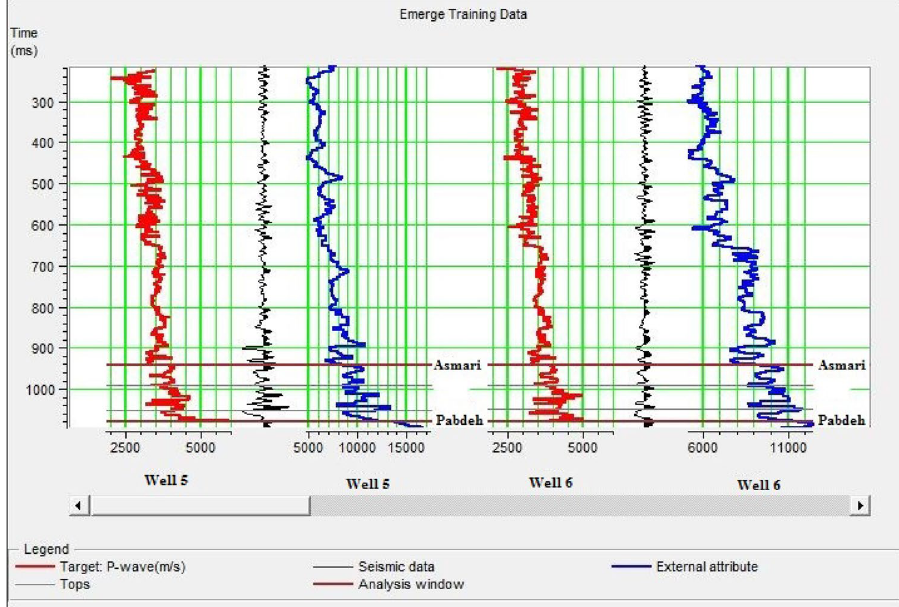
Fig. 12 Training data in well locations along with p-wave